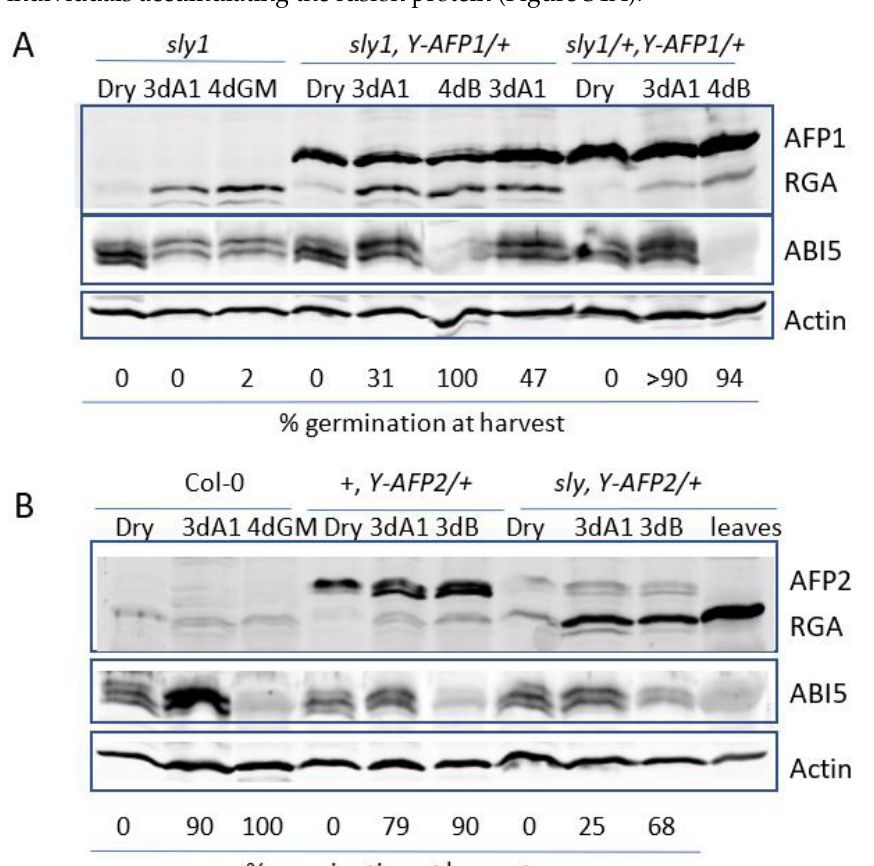
Figure 5. Immunoblot comparison of AFP, DELLA (RGA), and ABI5 protein accumulation in seeds and seedlings. Proteins were extracted from dry seeds or after 3d stratification, followed by 3d on GM + 1 µ M ABA (3dA1) or 4d on GM, supplemented with BASTA (4dB) for the transgenic lines. Actin was used as a loading control. ( A ) Comparison of sly1 background (lanes 1–3) with YFP-AFP1 transgenic line #3 (lanes 4–6) or line #4 (lane 7) or the F2 from the backcross of YFP-AFP1 #3 to Col-0 (lanes 8-10). ( B ) Comparison of wild-type (Col-0) (lanes 1–3), YFP-AFP2 in wild type (lanes 4–6), or sly1 backgrounds (lanes 7–10). Extract from rosette leaves is in lane 10.